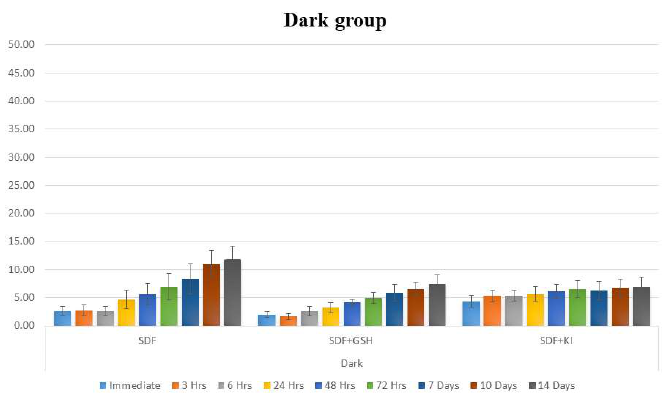
Figure 2. Bar chart showing mean ΔE for different tested groups for enamel substrate within each time interval under dark conditions.